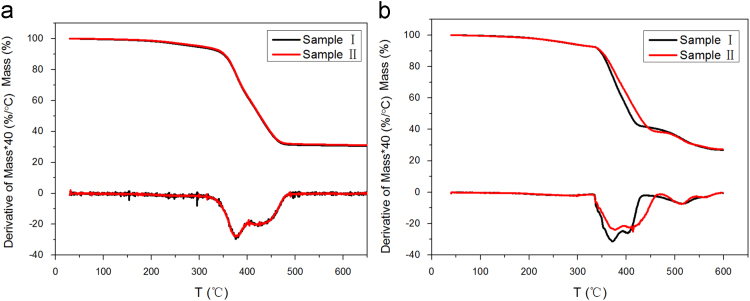
TG–DTG curves in different atmosphere of two NR composites: (a) in N2; (b) in air.